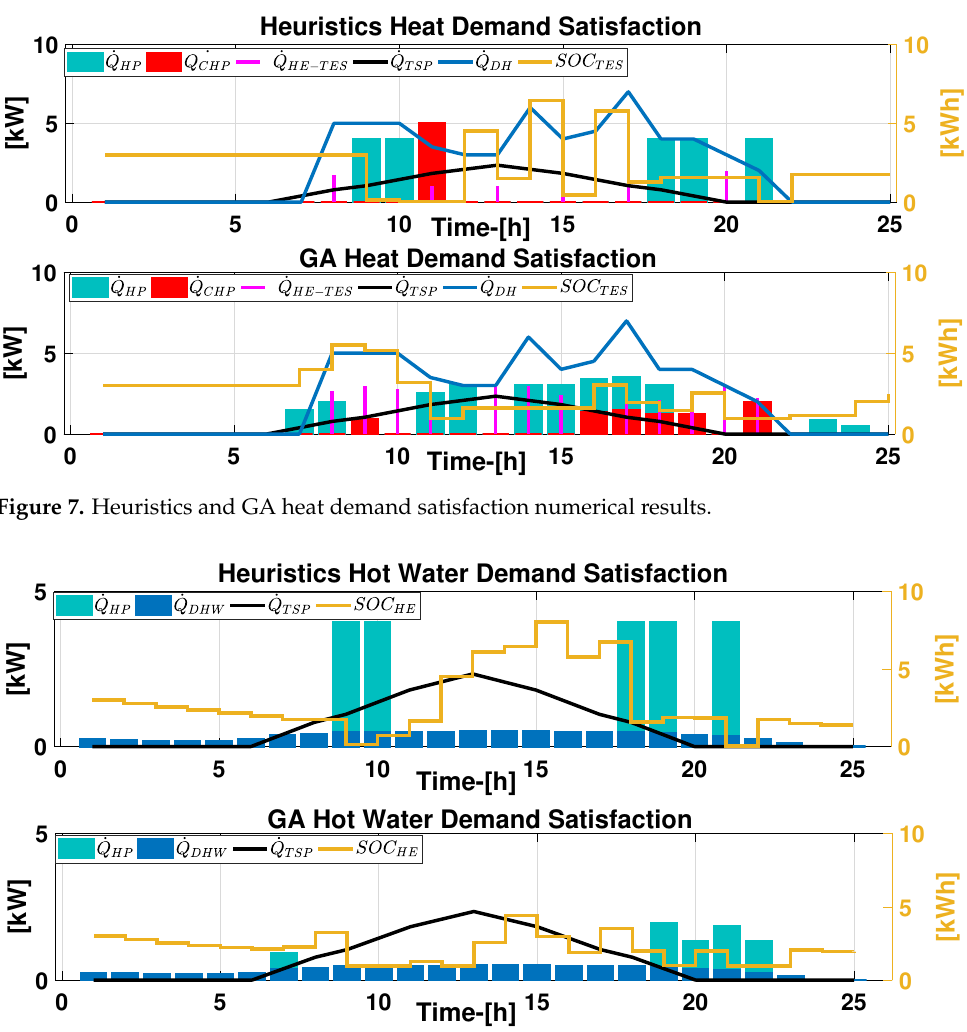
Figure 8. Heuristics and GA hot water demand satisfaction numerical